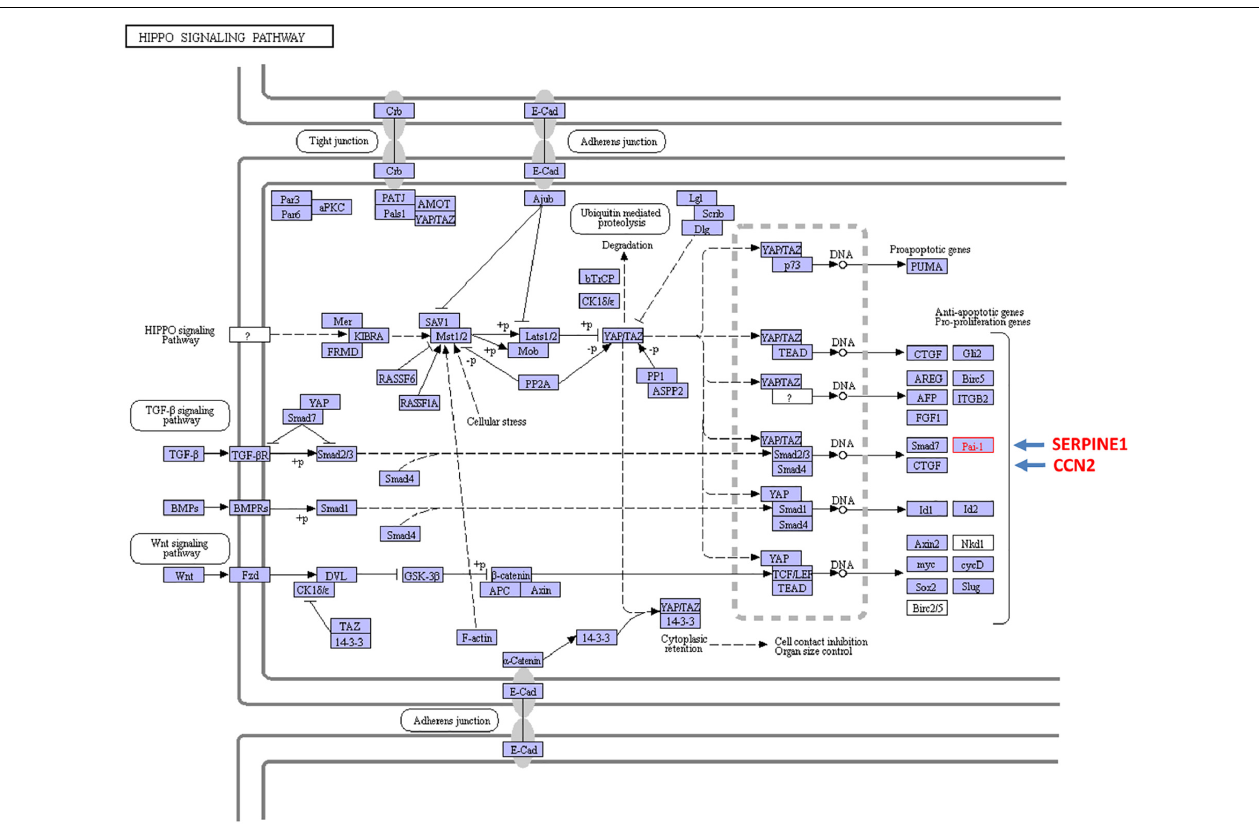
FIGURE 7 | Cross-talk between the TGF- β and the YAP/TAZ pathways impact expression of the profibrotic SERPINE1 and CCN2 genes. TGF- β activates a canonical signaling network that involves the SMAD2/3-dependent transcription of SERPINE1 and CCN2. It is also evident that non-canonical pathway engagement (e.g., Hippo) contributes to maximal TGF- β 1 SERPINE1 (PAI-1) and CCN2 (CTGF) expression by stimulating YAP/TAZ nuclear translocation and interaction with the TGF- β R-phosphorylated SMAD2/3 transcriptional effectors and the shuttle